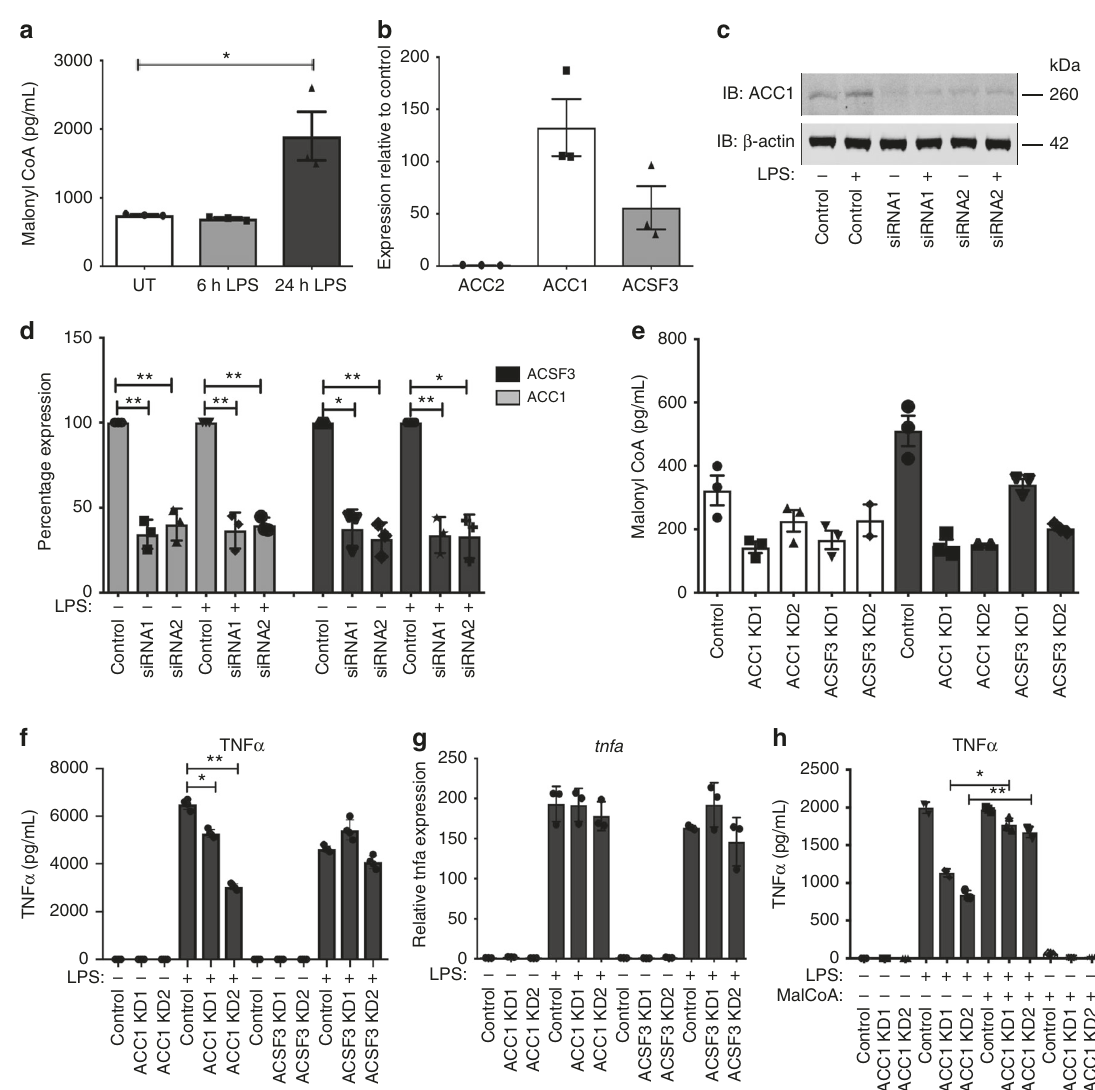
Fig. 1 Activation of macrophages increases malonyl-CoA levels and is needed for pro-in fl ammatory cytokine production. a Malonyl-CoA levels measured in untreated and LPS-treated (100 ng/mL) BMDM lysates using a malonyl-CoA ELISA. Mean + SEM, n = 3. b ACC1, ACC2 and ACSF3 mRNA expression measured via qPCR in BMDMs. Mean + SEM, n = 3. c ACC1 siRNA (48 h, 10 nM) knockdown (KD) measured by western blotting in untreated and LPS- treated (100 ng/mL, 24 h) BMDMs. β -actin used as a control. Representative of three independent experiments. d ACC1 and ACSF3 siRNA (48 h, 10 nM) KD levels relative to control siRNA, measured via qPCR in untreated and LPS-treated (100 ng/mL, 24 h) BMDMs. Mean + SEM, n = 4. e Malonyl-CoA levels measured in ACC1 and ACSF3 KD BMDM lysates using a malonyl-CoA ELISA. Mean + SD, representative of four independent experiments. f TNF α protein measured by ELISA (mean + SEM, n = 3) and g TNF α mRNA expression in 100 ng/mL LPS-treated (100 ng/mL, 6 h) ACC1 and ACSF3 KD BMDMs (mean + SD, representative of three independent experiments). h TNF α protein measured by ELISA in ACC1 KD BMDMs pre-treated with malonylCoA (1 mM, 2 h) followed by LPS (100 ng/mL, 6 h) (mean + SD, representative of three independent experiments). Unpaired t -test, * P < 0.05; ** P <